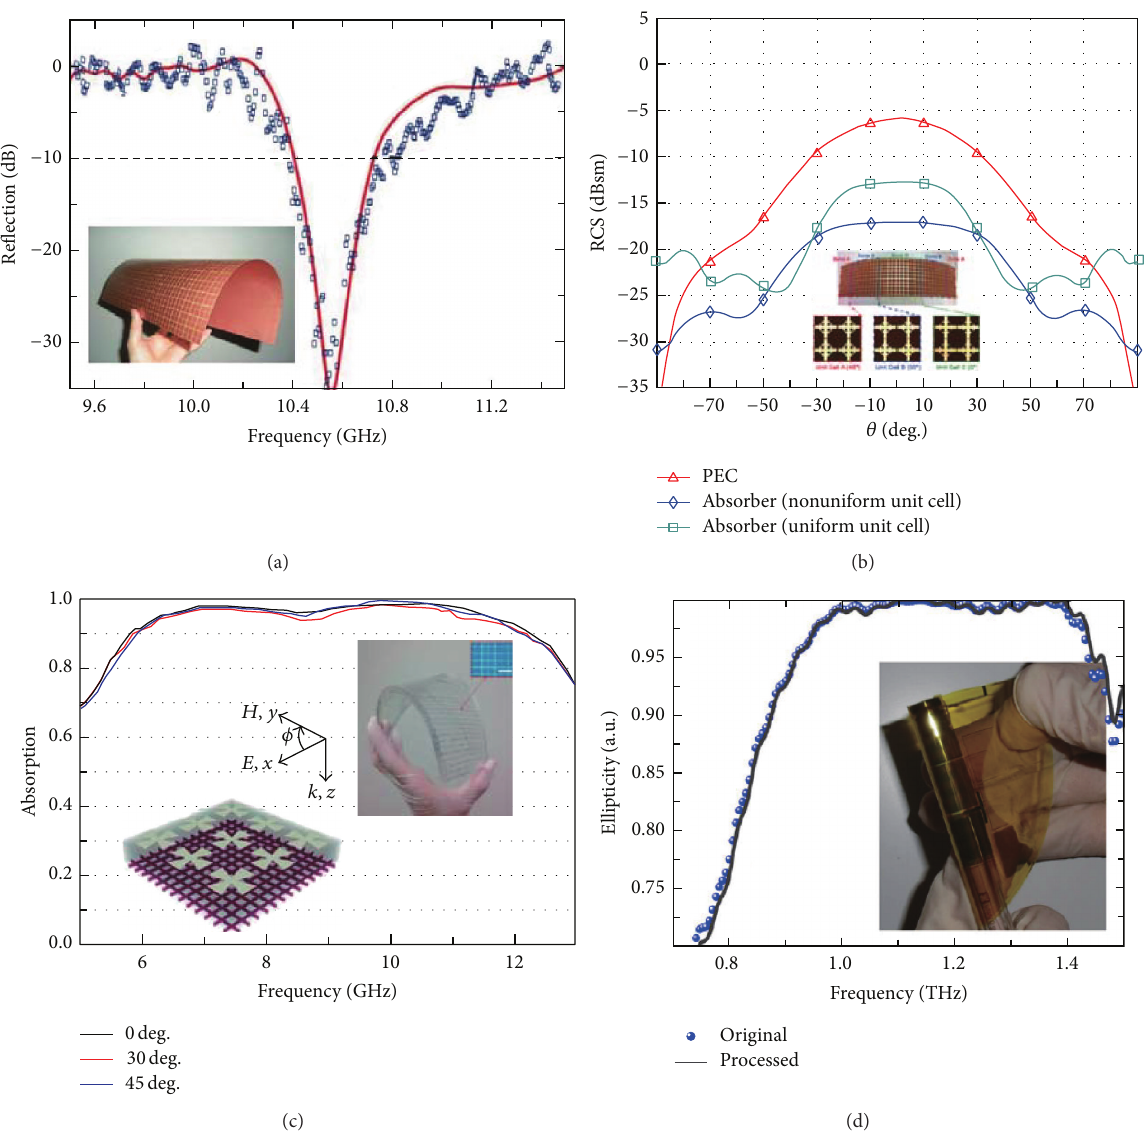
Figure 47: (a) Experimental results for a flexible metasurface absorber. (b) RCS reduction properties of nonuniform conformal metasurfaces. (c) Absorption of flexible absorbers fabricated on a PDMS substrate. (d) Elasticity of a flexible terahertz wave plate fabricated on polyimide. Figures are reproduced from (b)–(d) [239, 242,